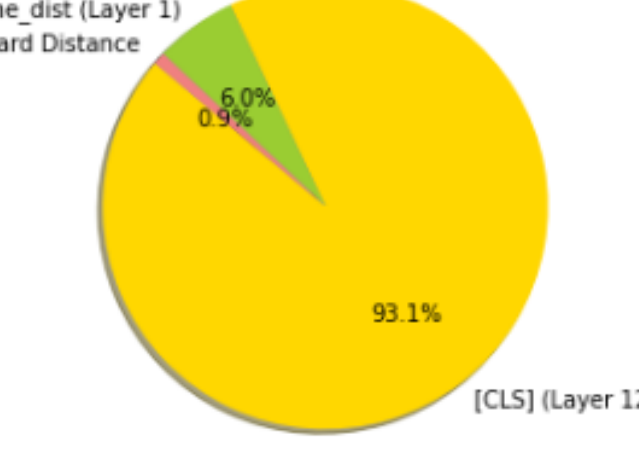
Figure 11. Proportion of weights learned for the best explanatory model (which used BioBERT representations and text